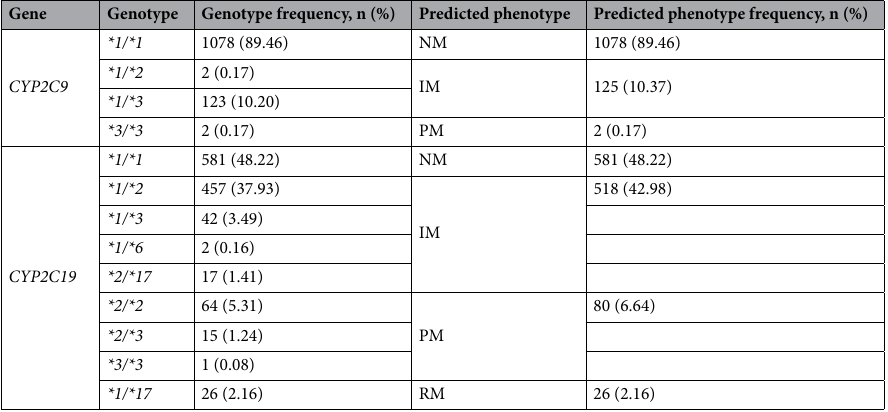
Table 3). Because of the lower turnaround time (~ 2.15 h), simple workflow, and lesser amount of DNA needed for PCR in TaqMan assay, we conclude that TaqMan SNP genotyping assay is better than Luminex xTAG v3 system for the detection of CYP2C19 variants in Thai population.